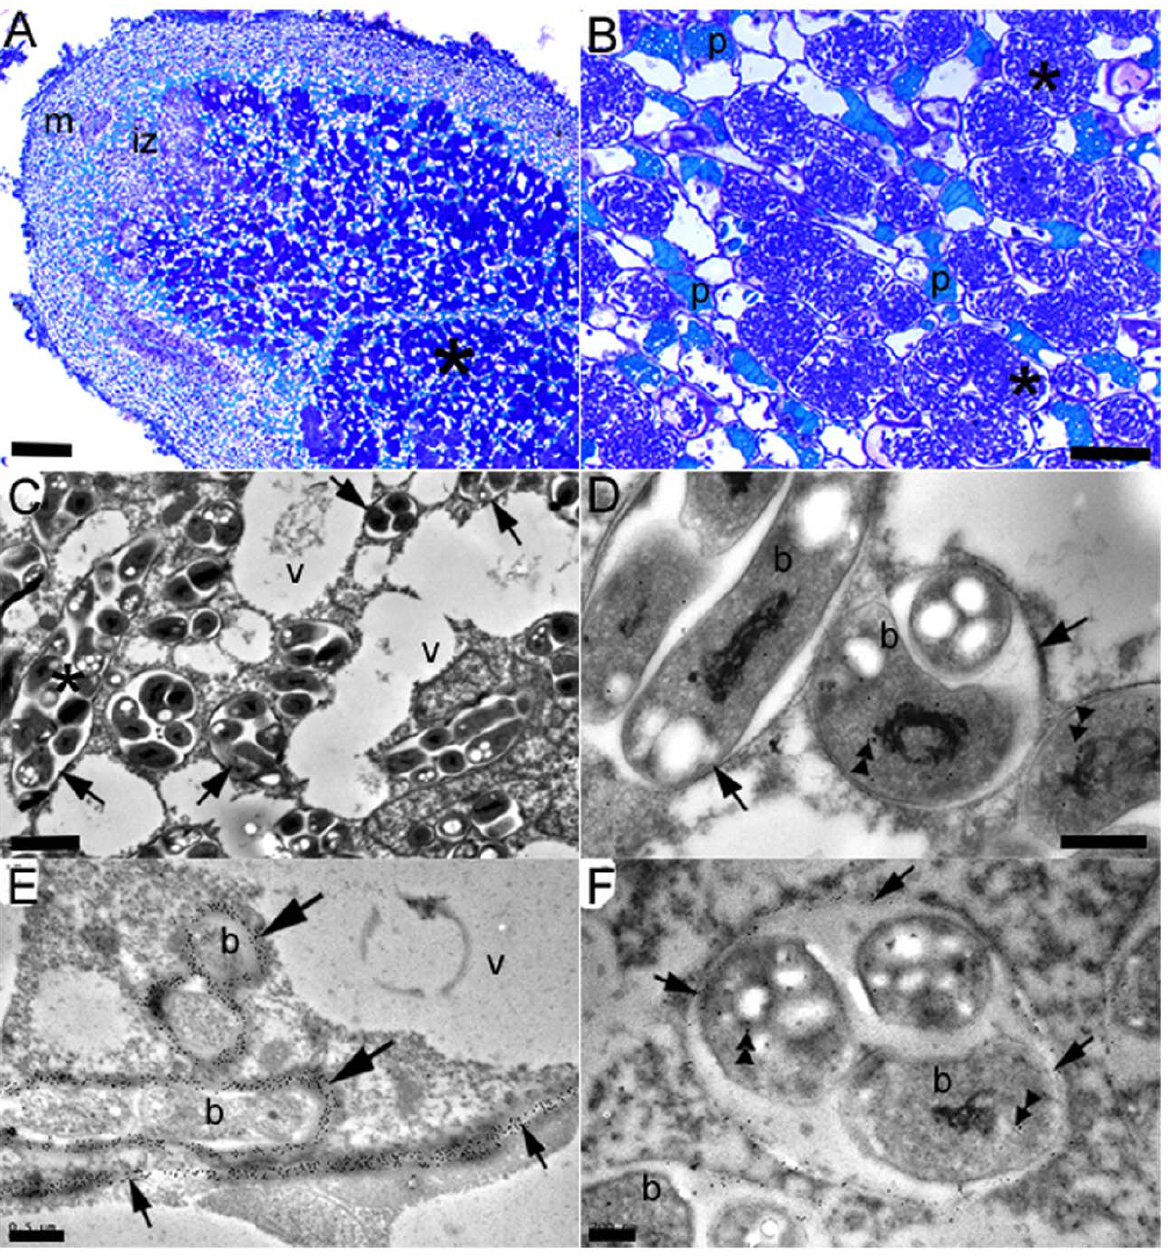
Figure 4. Light microscopy (A, B) and TEM (C–F) of mature, N-fixing D.wilsonii nodules at 63 dai with Bradyrhizobium strains DW12.5 (A–C, E) or DW10.1 (D, F). (A) Longitudinal section of a lobe from a large branched nodule shows the typical zonation of an indeterminate nodule, with an apical meristem (m), an invasion zone (iz) and a large infected N-fixing zone (*). Note the file of uninfected cells in the infected zone that contain phenolic compounds (arrow). (B) High magnification light micrograph of the infected zone shows the infected cells (*) to be filled with persistent infection threads (PITs), and to be interspersed with uninfected, phenolic-containing cells (p). (C) More detail of the infected cells can be seen under the TEM, where groups of bacteria, up to 15 per symbiosome (*), are enclosed in cell walls (arrows). v=vacuole. (D) Immunogold labeling of the nodules with an antibody against the nifH protein (Fe-protein) shows that the bacteroids (b) within the PITs/symbiosomes express this essential component of the nitrogenase enzyme complex (double arrowheads). Note the cell wall material surrounding the symbiosomes (arrows). (E) Infection threads in the invasion zone; note that the walls of these are strongly immunogold labeled with JIM5 (large arrows), a monoclonal antibody that recognizes a homogalacturonan epitope in pectin, which is a major component of plant cell walls. Note that the cell wall separating the infected cell from its neighbor is also strongly labeled (small arrows). b=bacteria, v=vacuole. (F) Persistent infection threads within the N-fixing zone: the walls of these are also immunogold labeled with JIM5 (arrows), thus confirming that the bacteroids (b) which are expressing nifH protein (double arrowheads) are also surrounded by cell wall material. Note, however, that the JIM5-labeled PIT walls are considerably thinner than those enclosing the invasive infection threads in (E). Serial sections to (D, E, F) that were treated with non-immune serum substituted for either the nifH protein or JIM5 antibodies showed no labeling (not shown). Bars, 200 m m (A), 20 m m (B), 2 m m (C), 500 nm (D, E), 200 nm (F).